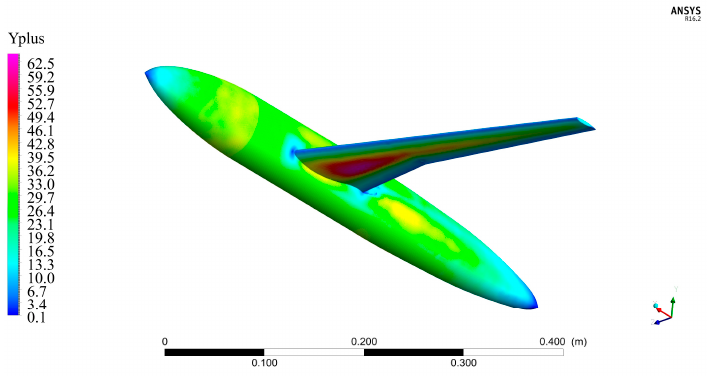
Figure 5. An example of Wall Y-plus parameter distribution over the surface of DLR-F4 wing and body.